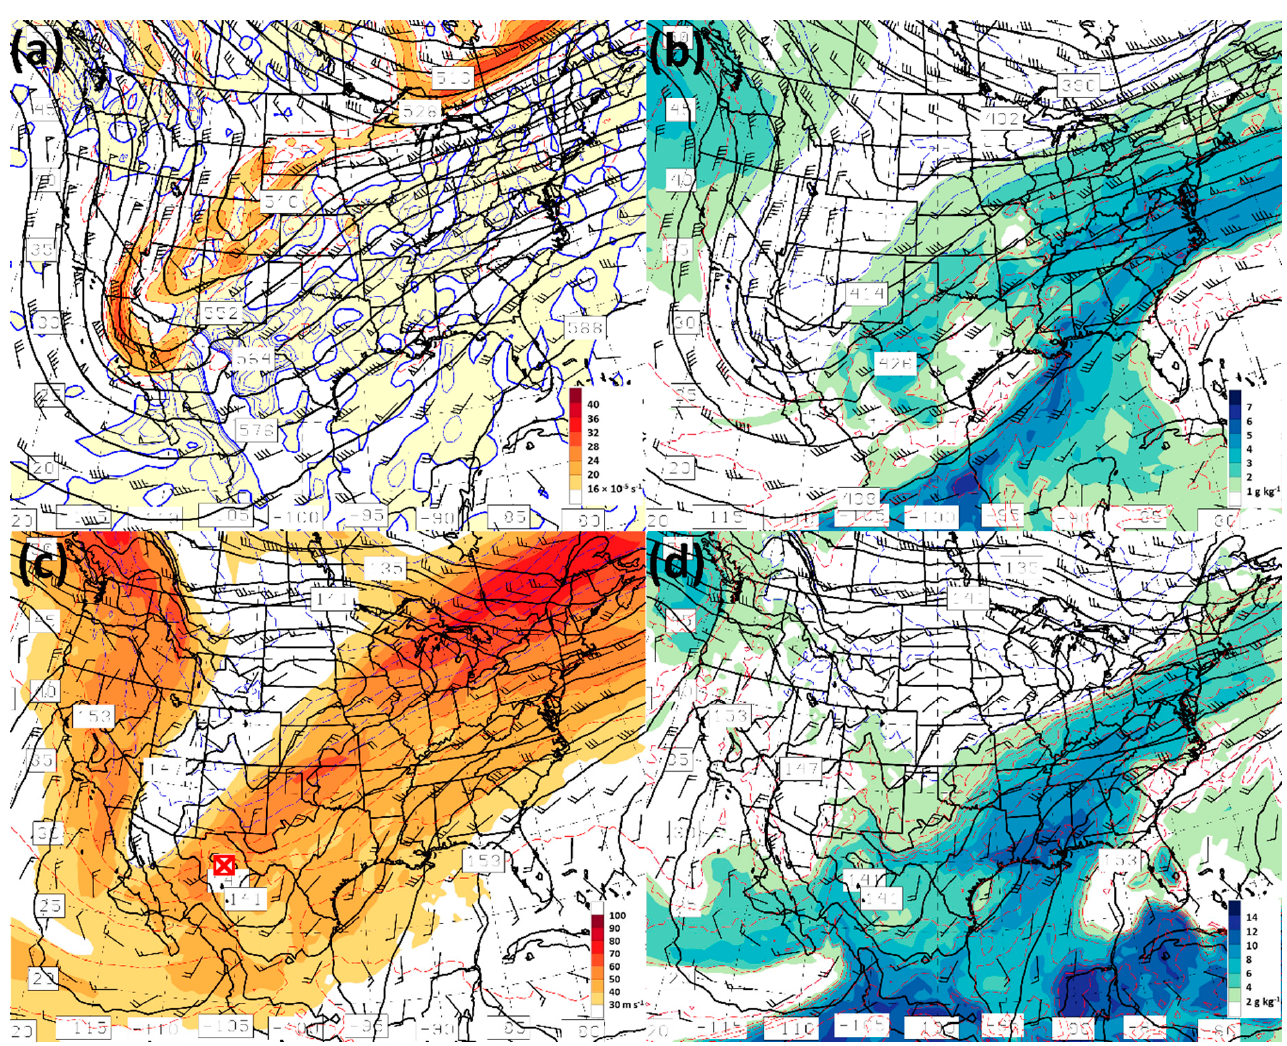
Figure 4. As in Figure 3, except GFS − analyzed fields valid at 0000 UTC 5 February 2020 of: ( a ) 500 hPa level geopotential height (dam, solid black contours), absolute vorticity × 10 − 5 (s − 1 , shading and red dashed contours), and wind vectors (kt) and 700 hPa level rising motion × 10 − 3 (hPa s − 1 , vanilla shading and blue solid contours); ( b ) 600 hPa level geopotential height (dam, solid black contours), mixing ratio (g kg − 1 , shading), equivalent potential temperature (K, final blue (first red) dashed contour value is 304 K (310 K)), and wind vectors (kt); ( c ) 850 hPa level geopotential height (dam, solid black contours) and wind vectors (kt) and 1000-500 hPa layer thickness (dam, final blue (first red) dashed contour value is 540 dam (546 dam)), and 300 hPa level wind speed (m s − 1 , shading); and ( d ) 850 hPa level geopotential height (dam, solid black contours), mixing ratio (g kg − 1 , shading), wind vectors (kt), and equivalent potential temperature (K, final blue (first red) dashed contour value is 280 K (286 K)). Red cross-square symbol in panel ( c ) represents the locally dominant 850 hPa level cyclone center.